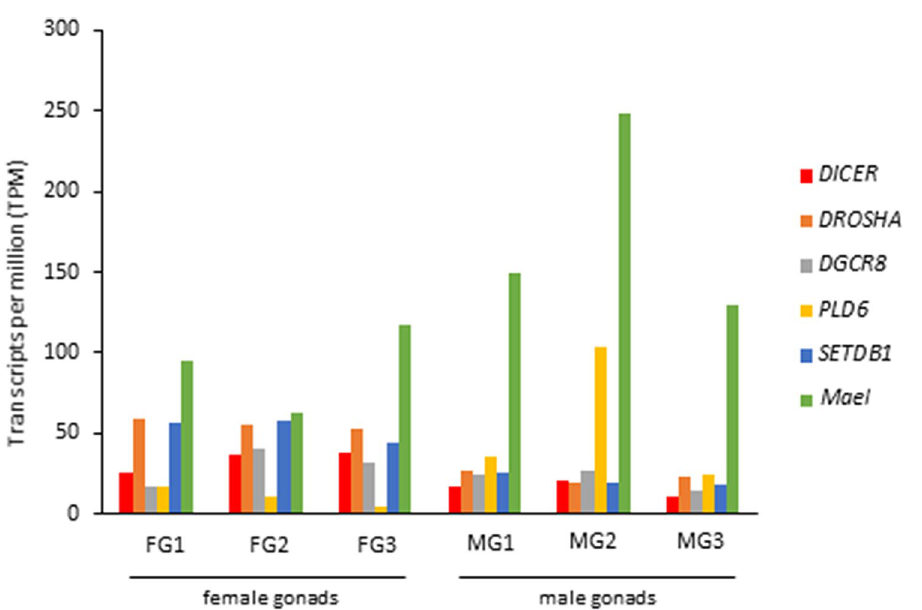
Figure 3. Expression levels of genes involved in small RNA biogenesis. Expression values of genes encoding proteins involved in small RNA production detected in Cynops orientalis transcriptomes obtained from the female and male gonadal tissues. FG female gonad, MG male